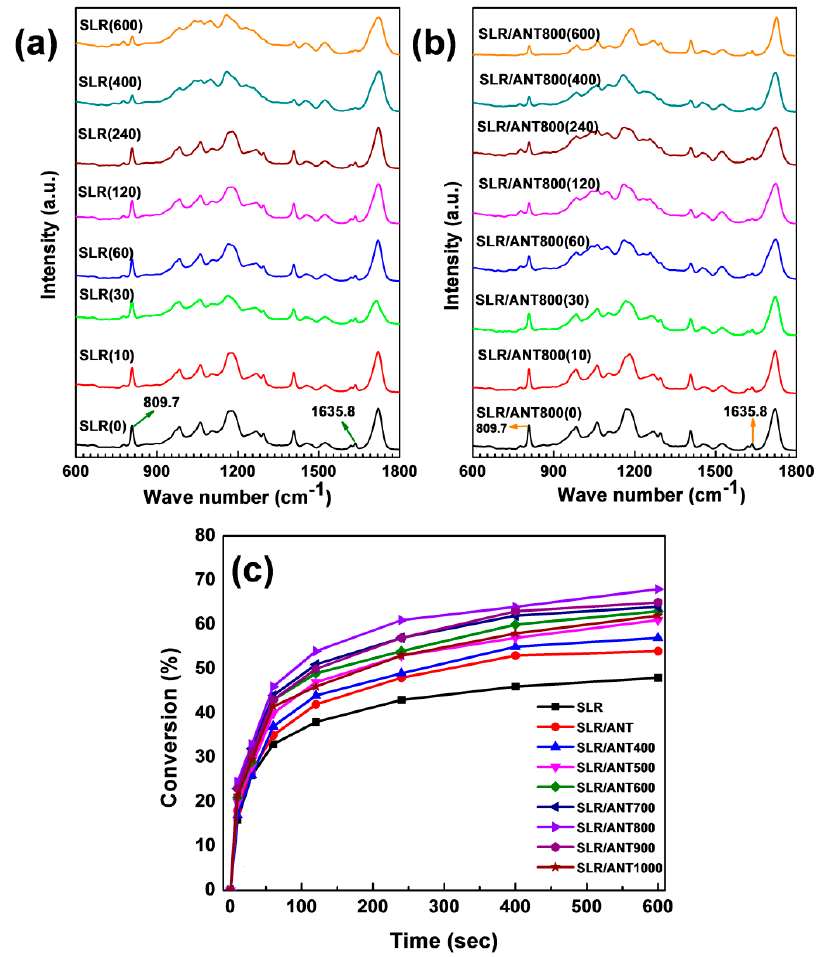
Figure 13. A real time FTIR analysis of photopolymerization of neat SLR and SLR / ANT800. ( a ) Neat SLR and ( b ) SLR / ANT800 nanofillers composite in di ff erent periods of UV irradiation time intervals starting from 0 s to 600 s. ( c ) Percent conversion graph of neat SLR and SLR /